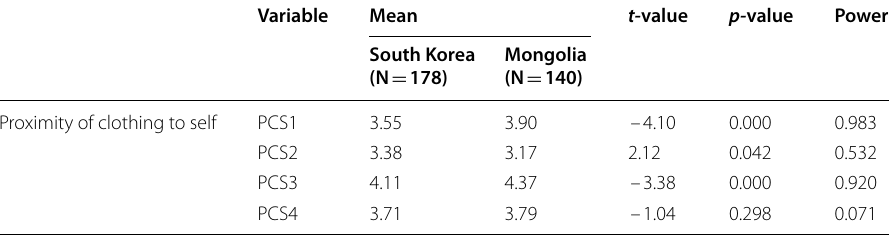
The mean value for PCS is based on the 5‑point scale PCS1 Clothing in Relation to Self as Structure, PCS2 Clothing in Relation to Self as Response to Others Judgment, PCS3 Clothing in Relation to Self‑esteem, PCS4 Clothing in Relation to Body Image and Body